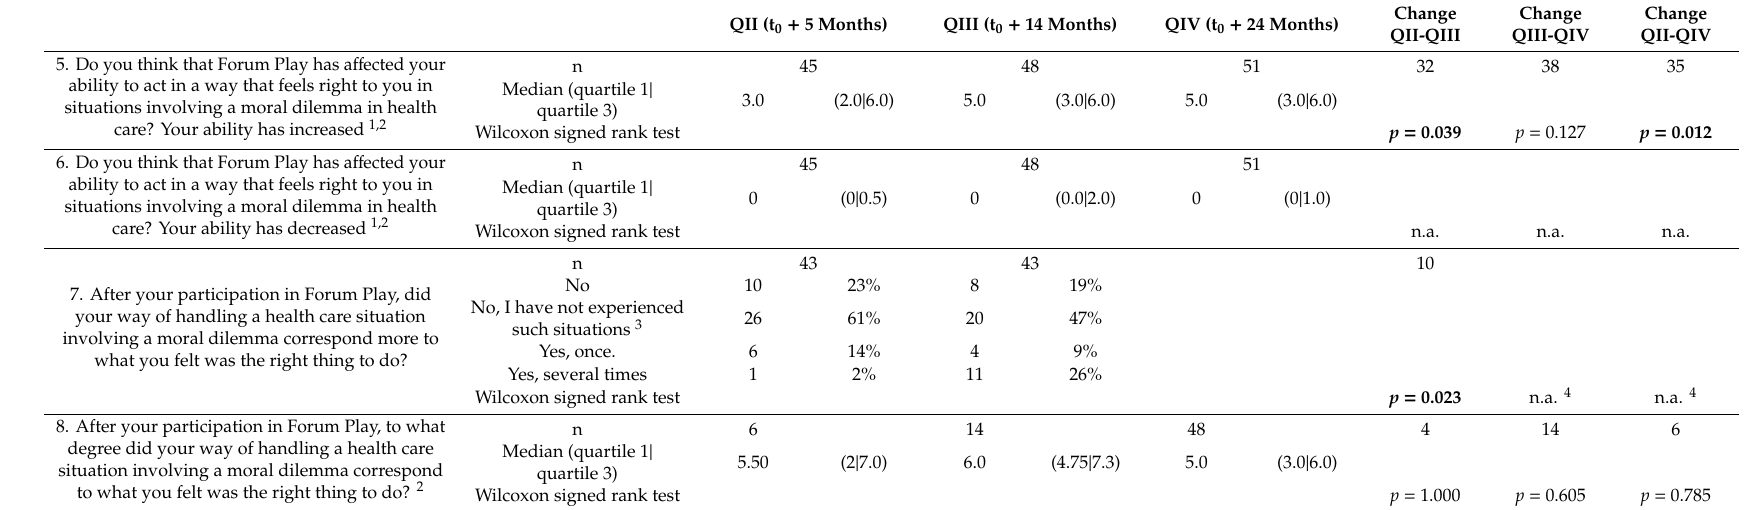
Table 4. Variables relevant for Hypothesis 2: FP participants’ ability to act according to their moral beliefs in situations with a moral dilemma.